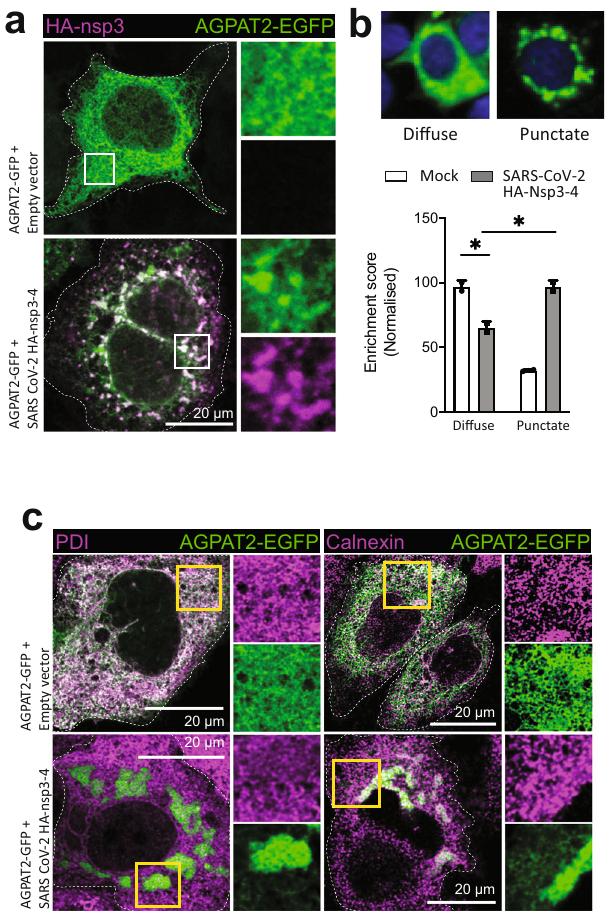
Fig. 5 Selective recruitment of AGPATs to SARS-CoV-2 induced DMVs. a Change of subcellular localization of AGPATs upon expression of SARS-CoV-2 nsp3-4. Huh7-derived cells transiently expressing AGPAT2-EGFP were transfected with a SARS-CoV-2 HA-nsp3-4-V5 expression construct or the empty vector. After 48h, cells were stained with HA-speci fi c antibody and examined by confocal microscopy. Maximum intensity projections are shown. Enrichment score indicates the likelihood of cells showing a punctate or diffuse staining pattern. Two biologically independent experiments showed similar results. b Clustering of AGPAT2-EGFP in SARS-CoV-2 HA-nsp3-4-V5 expressing cells. Huh7-Lunet/T7 cells were co-transfected with AGPAT2- EGFP and SARS-CoV-2 HA-nsp3-4-V5 or the empty vector. Twenty-four hours later, cells were fi xed and ~1000 cells per condition were separated into two morphotypes (diffuse or punctate) using CellPro fi ler Analyst-based semi- supervised classi fi er. Signi fi cance was calculated using an ordinary one-way ANOVA. * p = 0.0211. A representative experiment from three biologically independent experiments is shown. c AGPAT clustering occurs independent of ER remodeling induced by nsp3-4. Huh7-Lunet cells expressing AGPAT2-EGFP and HA-nsp3-4-V5 were stained for the ER markers protein disul fi de isomerase (PDI) and calnexin and analyzed by confocal microscopy. Two biologically independent experiments showed similar results. Light microscopy images are maximum intensity